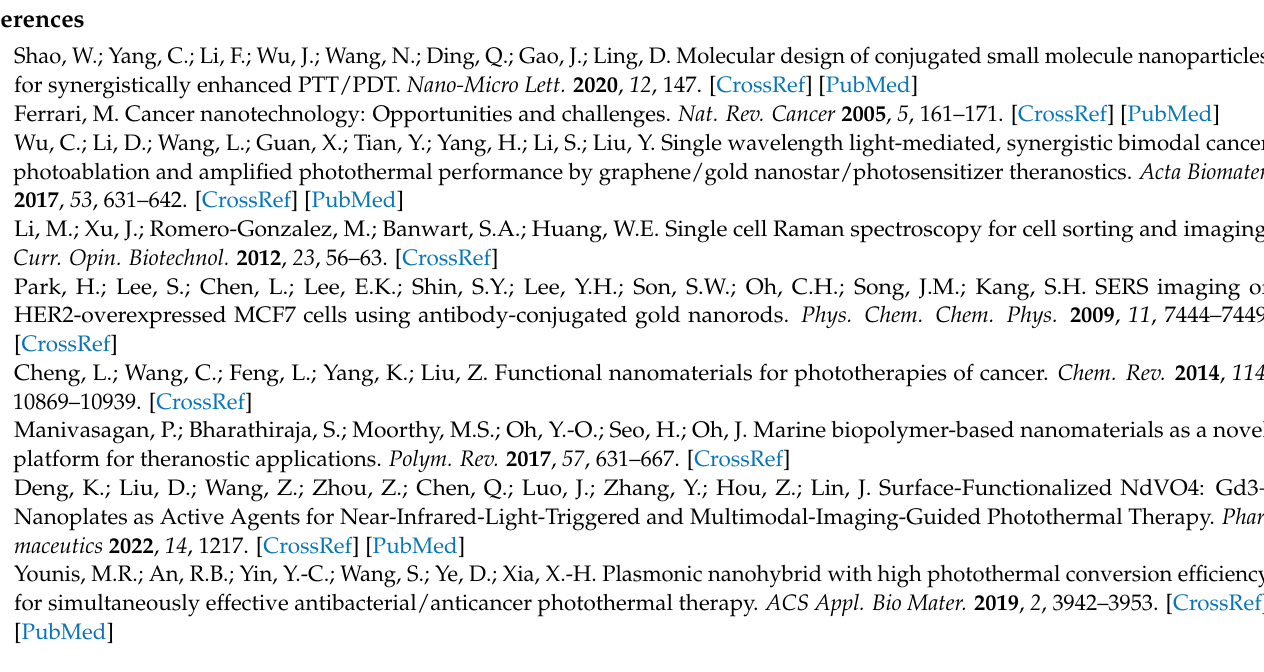
Figure S2: Viability of BLO-11 cells treated with gold nanorod (GNR), methylene blue-loaded mesoporous silica-coated gold nanorod (MB-GNR@mSiO 2 ), graphene oxide (GO), and methylene blue-loaded mesoporous silica-coated gold nanorods on graphene oxide (MB-GNR@mSiO 2 -GO) (200 µ L/mL) for 12 h (a) and 48 h (b) with or without 785 nm laser irradiation at 0.8 W/cm 2 for various time points (0, 10, 30, and 50 min). Data were expressed as mean ± S.D ( n = 3); Figure S3: Viability of MDA-MB-231 cells treated with gold nanorod (GNR), methylene blue-loaded mesoporous silica-coated gold nanorod (MB-GNR@mSiO 2 ), graphene oxide (GO), and methylene blue-loaded mesoporous silica-coated gold nanorods on graphene oxide (MB-GNR@mSiO 2 -GO) (200 µ L/mL) for 48 h with or without 785 nm laser irradiation at 0.8 W/cm 2 for various time points (0, 10, 30, and 50 min). Data were expressed as mean ± S.D. ( n = 3, * significant p < 0.05, ** significant p <